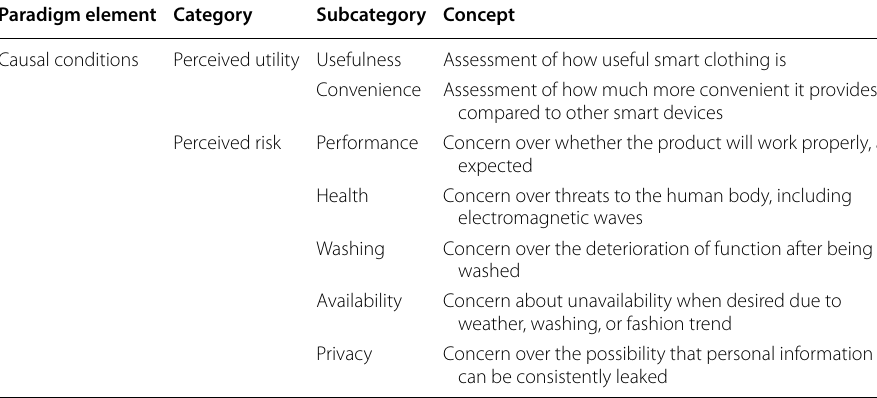
Table 3 Categories, subcategories, and concepts of causal